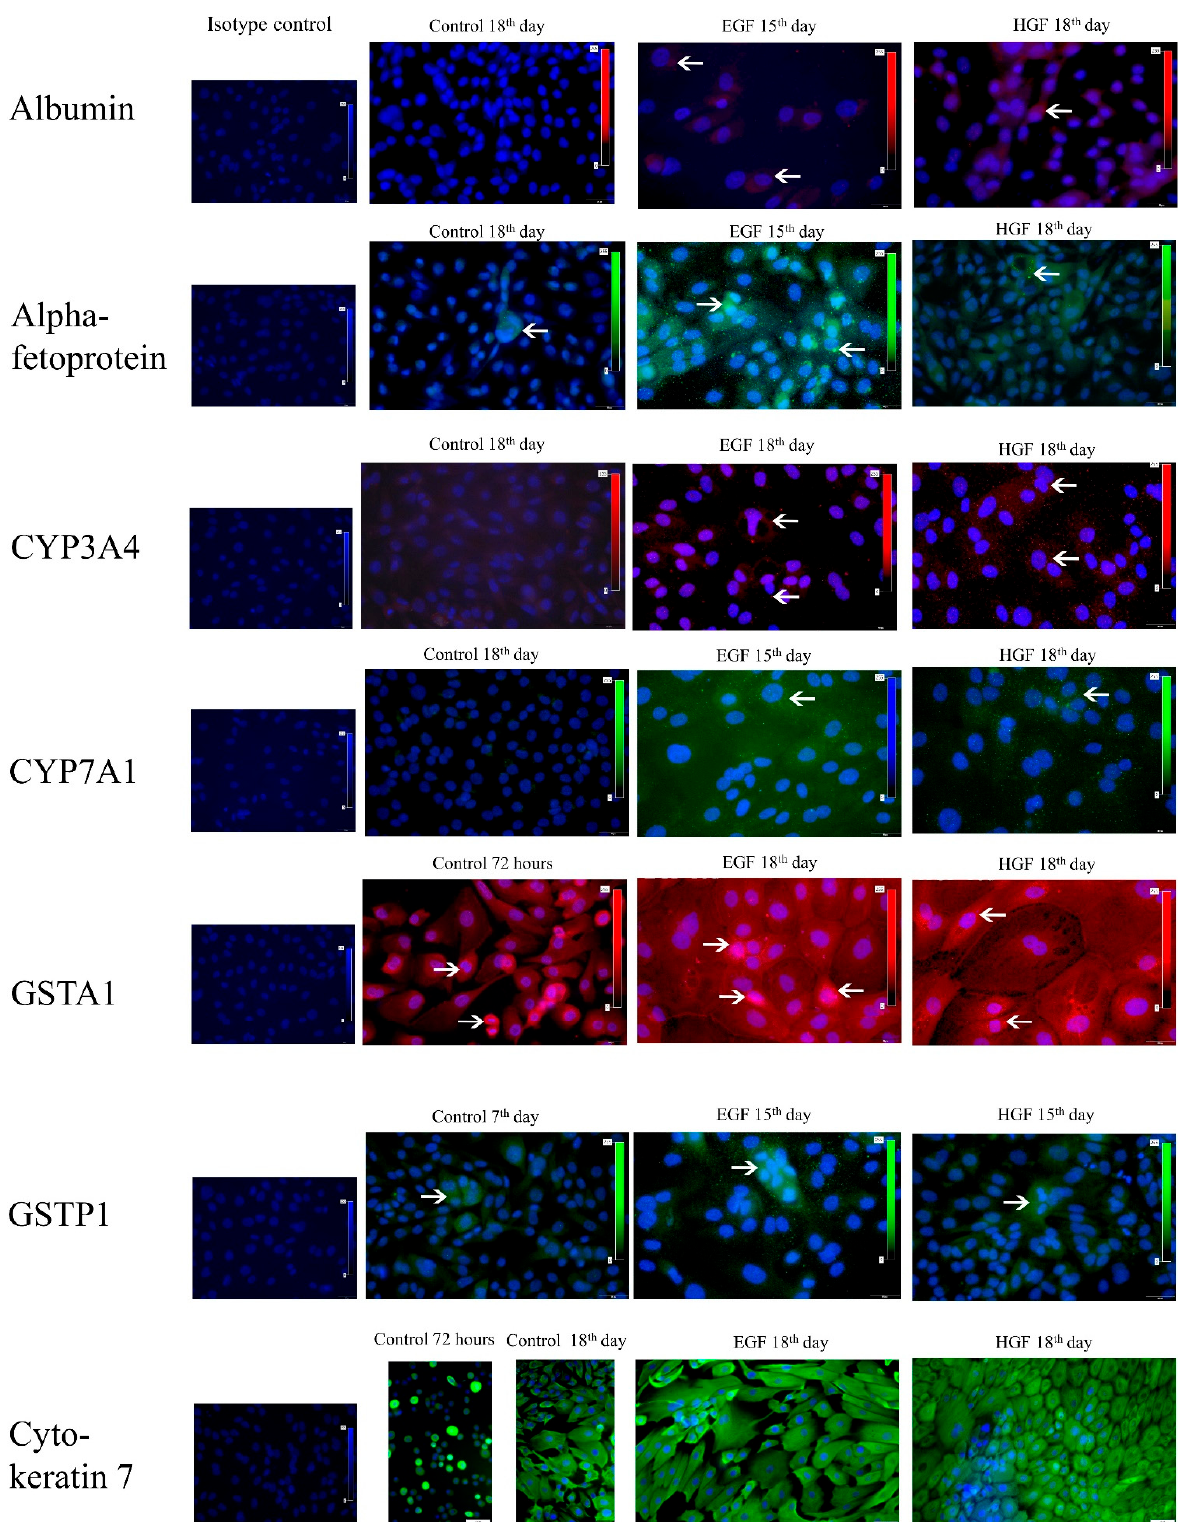
Figure 5. Immunofluorescent detection of hepatic markers—ALB, CYP4A4, CYP7A1; hepatoblast markers—AFP, GSTA1; cholangiocytic markers—GSTP1; and epithelial markers—CK7. Green colour—AFP, CYP7A1, GSTP1, CK7. Red colour—ALB, CYP3A4, GSTA1. The arrows indicate examples of positively stained cells. Appropriate isotype controls are also included. Magnifica- tion 400 ×